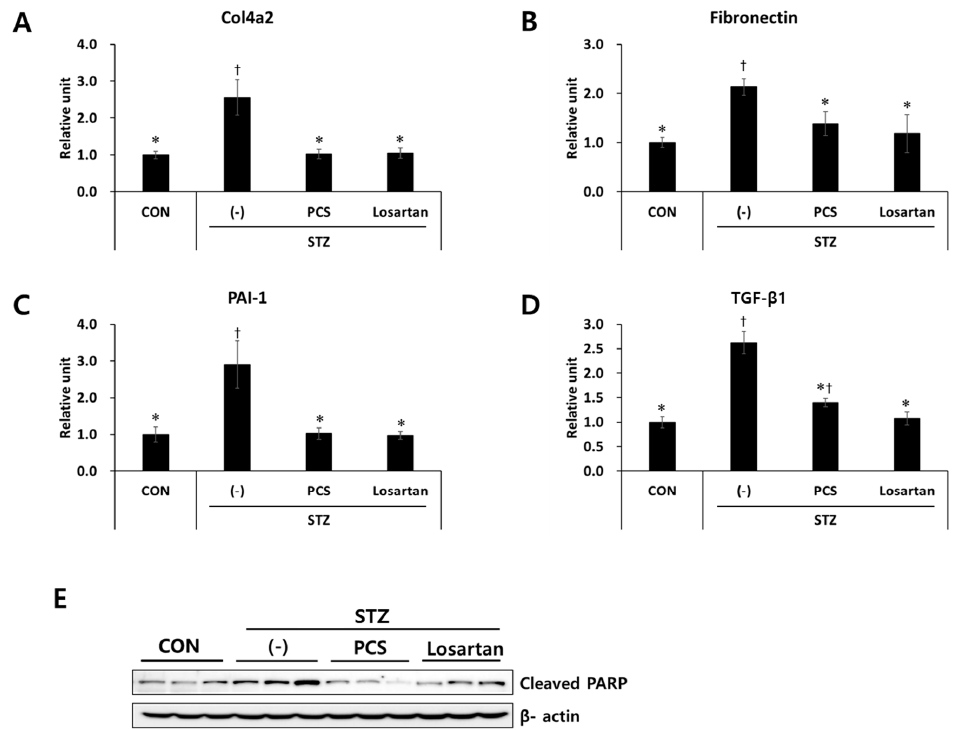
Figure 3. Effect of PCS extract on the expression of fibrosis-related genes in PCS extract-treated, STZ-induced diabetic mice. Mice were treated as described in Figure 1 ( n = 8–11/group). After 8 weeks of PCS extract treatment, total RNA was extracted from the kidney tissue and qRT-PCR analysis was performed for: ( A ) Col4a2; ( B ) fibronectin; ( C ) PAI-1; and ( D ) TGF- β 1. The mRNA levels were normalized with those of cyclophilin. ( E ) Protein was extracted and western blotting analysis was carried out for cleaved PARP. †, p < 0.05 vs. CON mice. *, p < 0.05 vs. (-)/STZ mice.